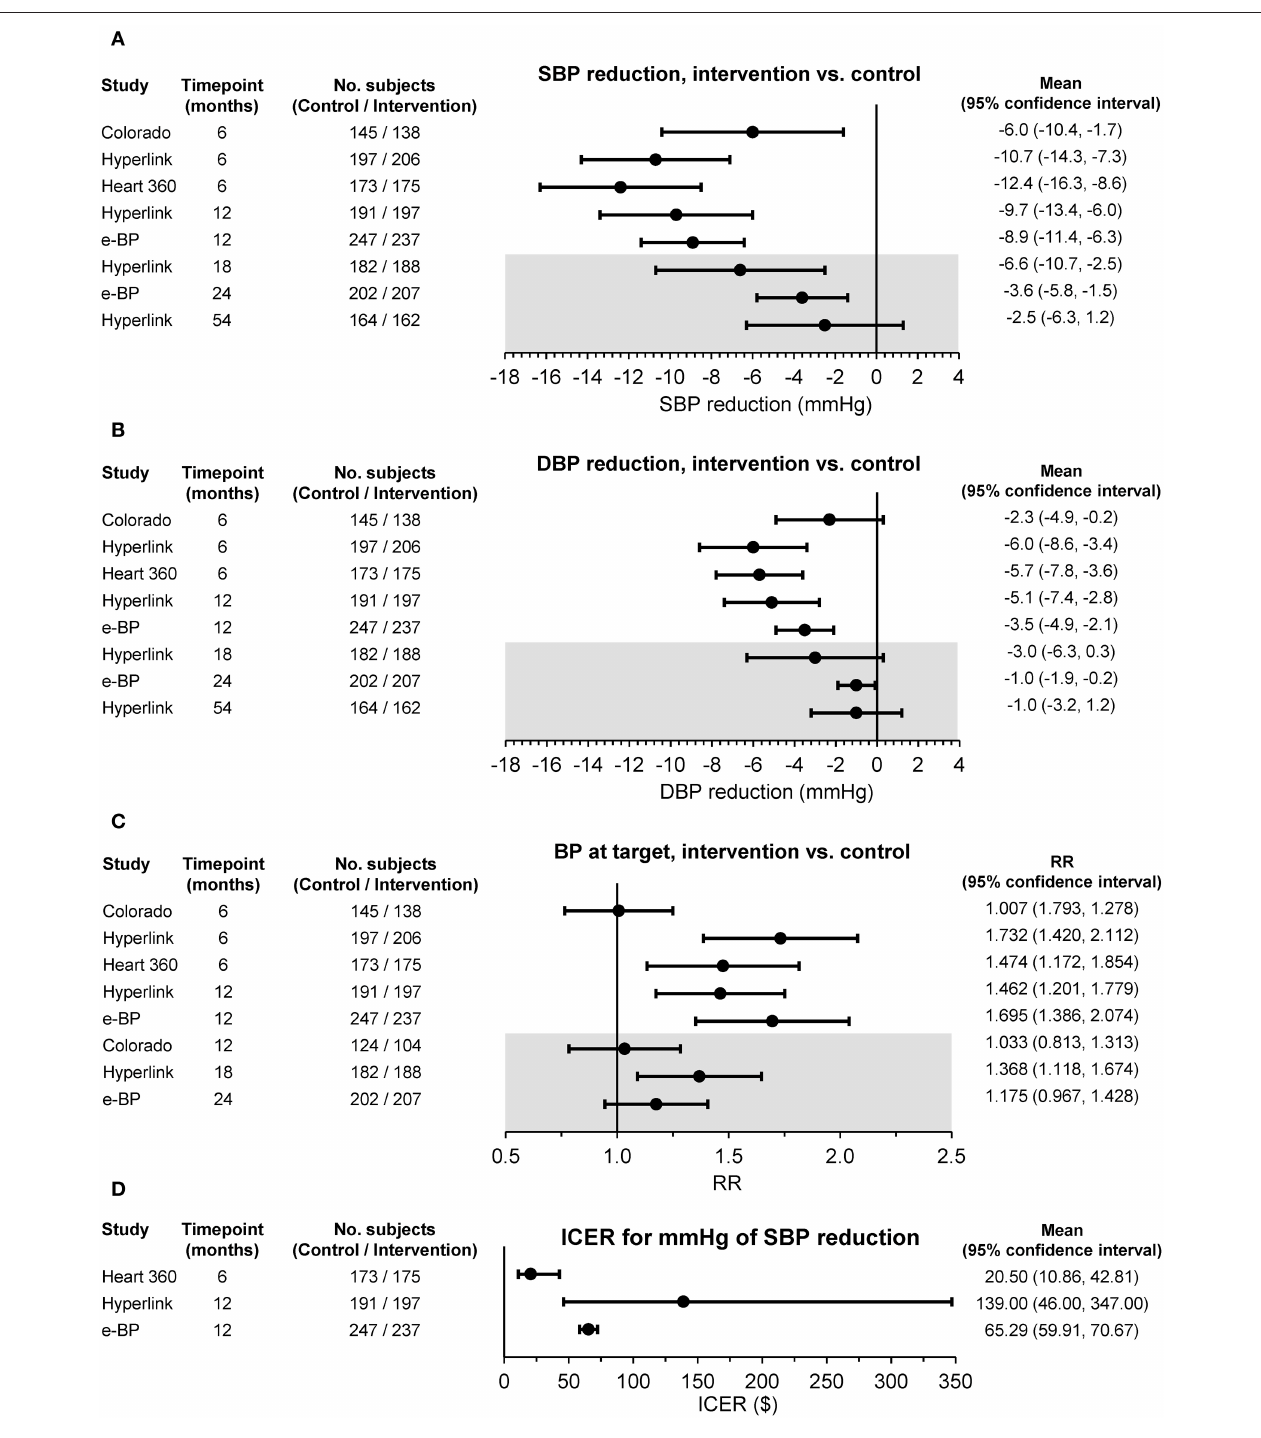
FIGURE 3 | (A) Changes in office systolic blood pressure (SBP) and (B) diastolic blood pressure (DBP), (C) percentages of subjects with office blood pressure (BP) at target, and (D) incremental cost-effectiveness ratio (ICER) between the intervention and usual care group in randomized controlled studies based on pharmacist-led telehealth care. Differences are shown as mean or relative risk (RR) and 95% confidence interval at different time points. The gray insert refers to the period of the study following the withdrawal of the intervention [from (32) by permission].